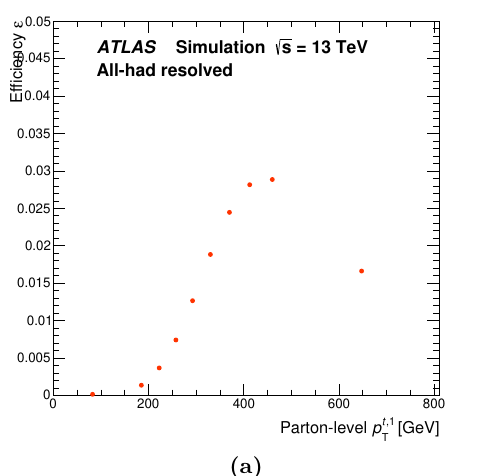
Figure 4 . The (a) efficiency (cid:15) corrections in bins of the parton-level p t, 1 level migration matrix (evaluated with the MC t ¯ t signal sample) for the transverse momentum of the leading top quark. The acceptance correction f